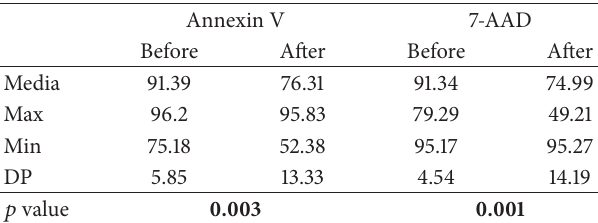
Table 3: Representation of viability and integrity cells before cryopreservation and after